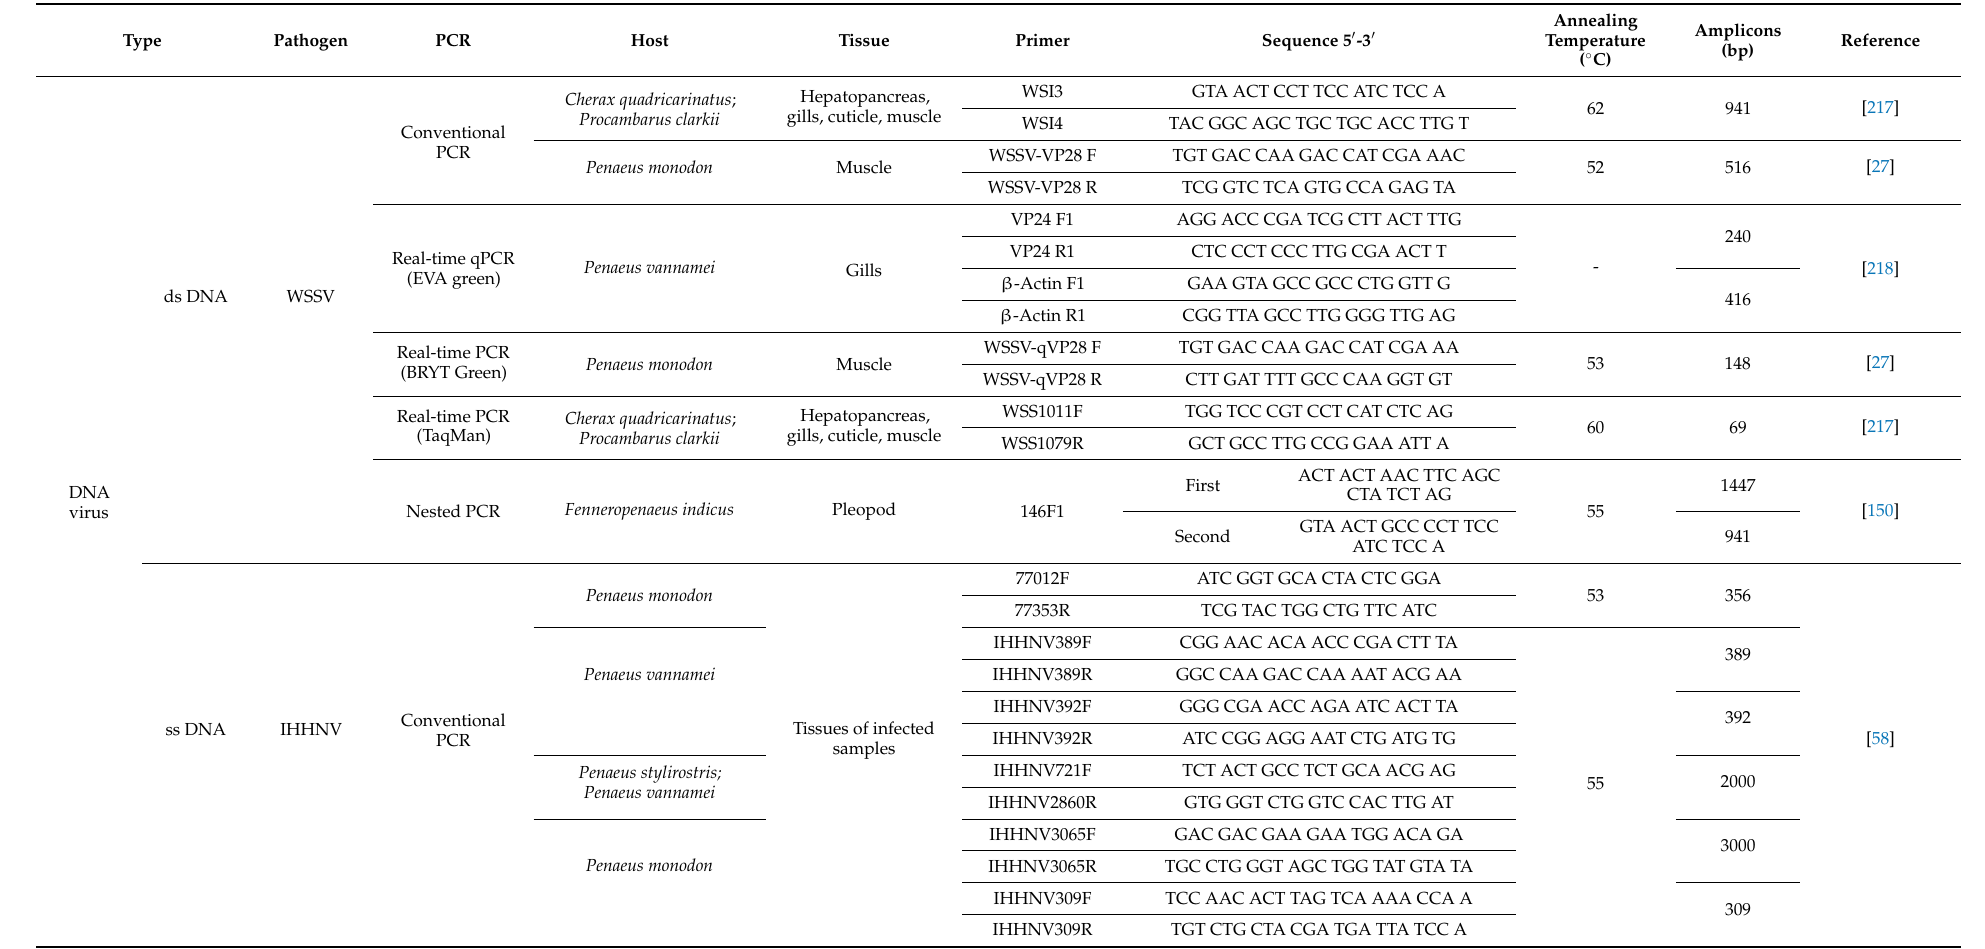
Table 5. Summary of the DNA and RNA viral diseases PCR